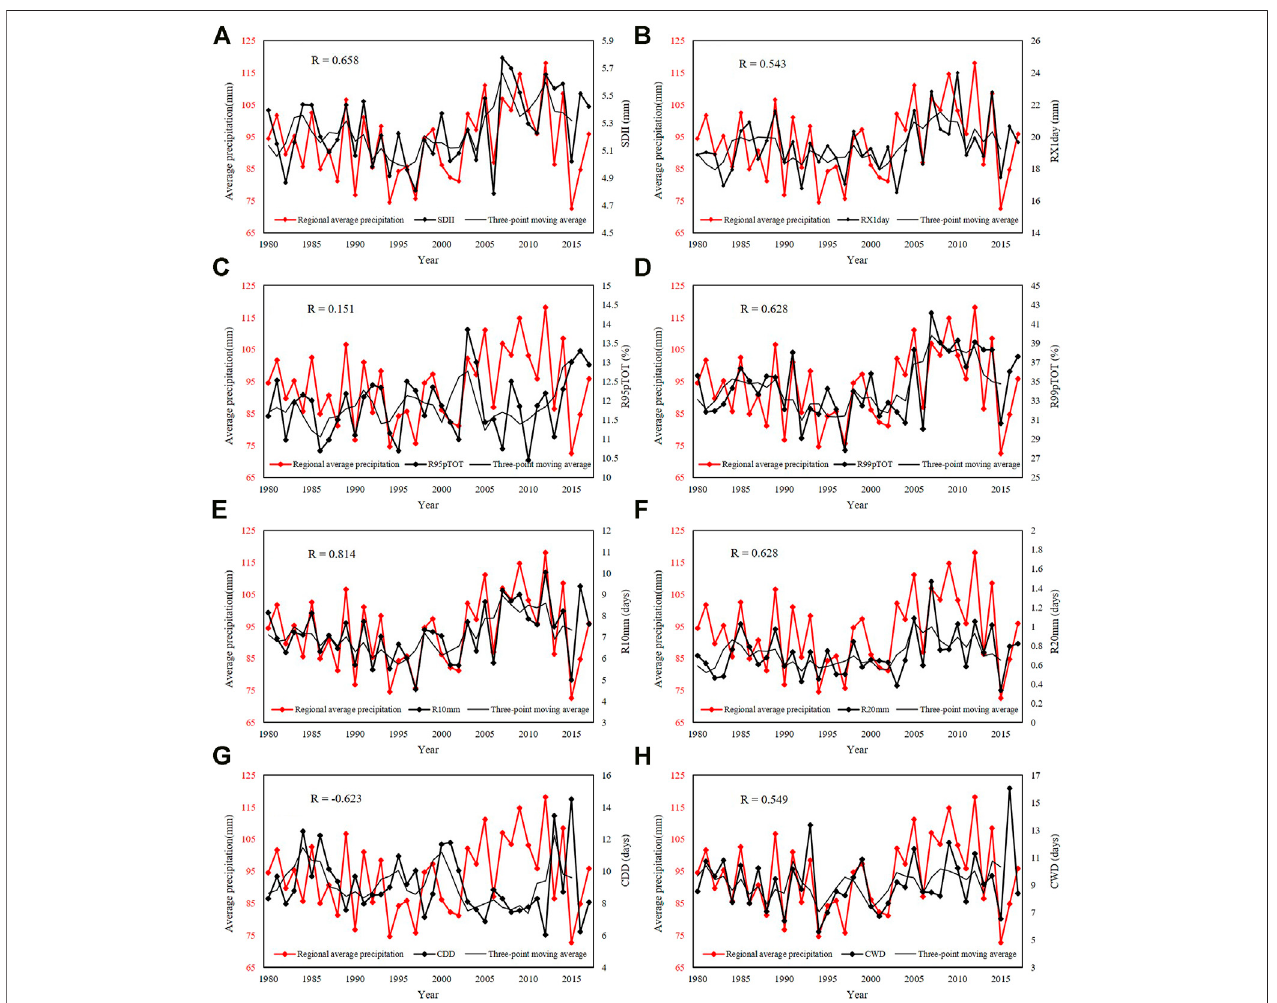
FIGURE 2 | The interannual variation of the eight extreme precipitation indices (A) SDII; (B) RX1 days; (C) R95dTOT; (D) R99pTOT; (E) R10mm; (F) R20mm; (G) CDD; and (H) CWD; the meaning of abbreviation for the six indices is shown in Table 1 , together with the regional mean precipitation over the TRHR. The correlation coef fi cientbetweeneachindexandtheregionalaverageprecipitationisshownintheleftcorner,andsevenindiceshavepassedthe0.05signi fi cancelevelexceptforthe precipitation fraction due to wet days (R95pTOT).